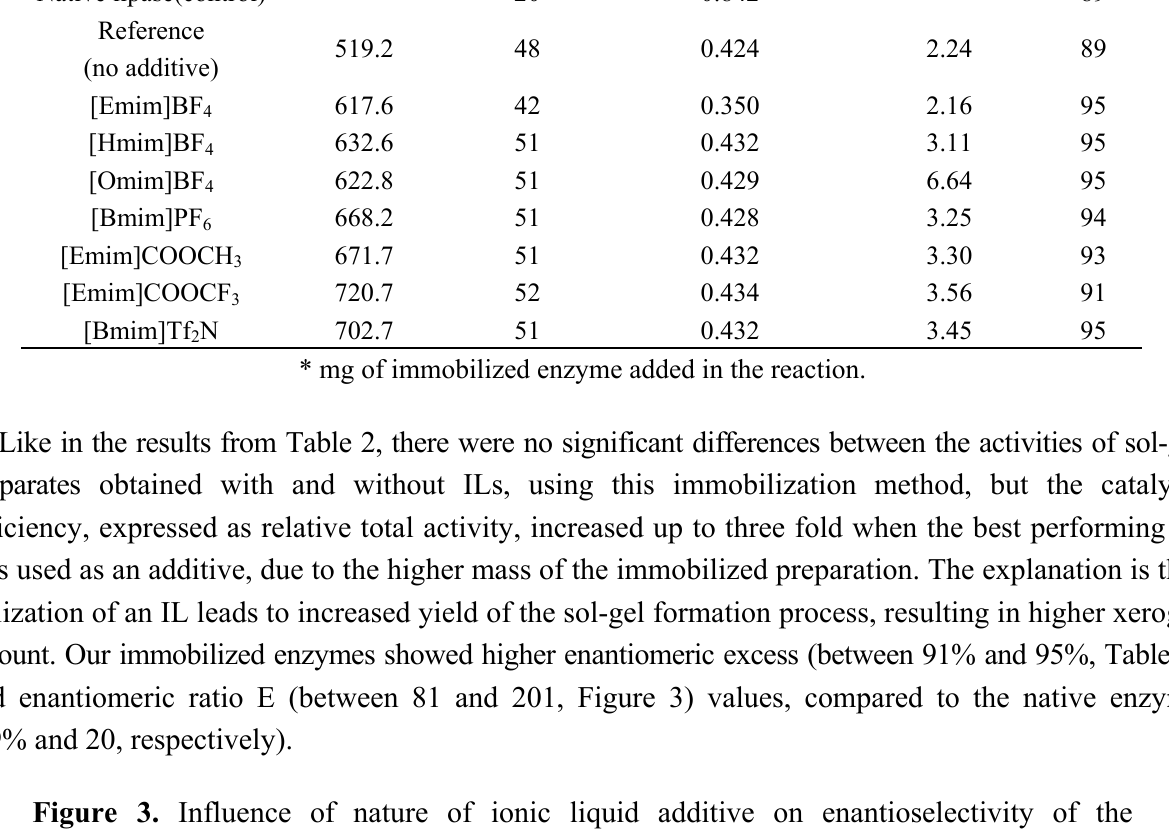
Figure 3. Influence of nature of ionic liquid additive on enantioselectivity of the immobilized lipase, in the enantioselective acylation of 2-octanol, at 24 h reaction time. The reference sol-gel was prepared without any